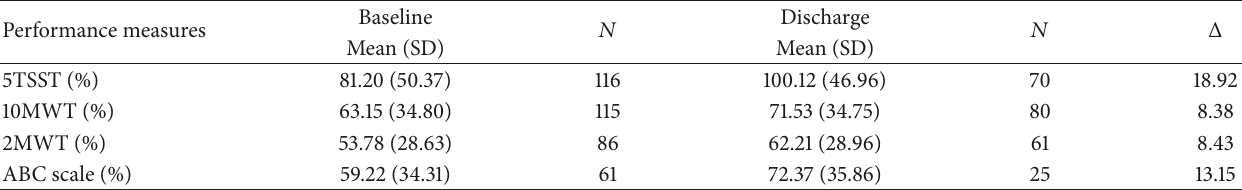
Table 6: Performance measure comparison of baseline to discharge (percentage of